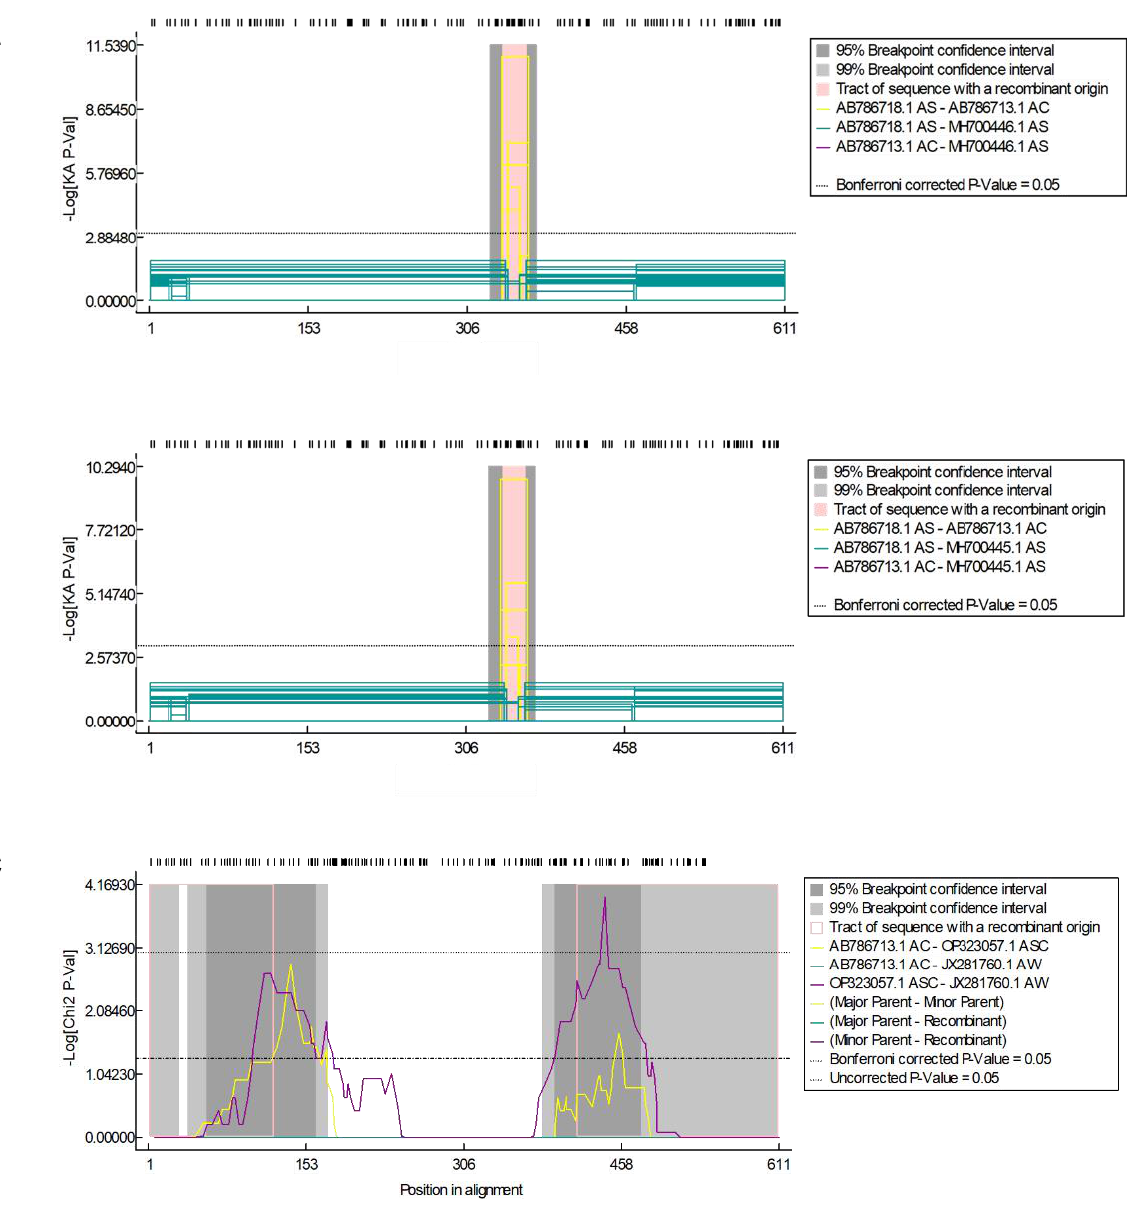
Figure 5. Recombination hotspots analysis. ( A , B ) Recombinant event 1 GENECONV output of se- quences ID MH700446.1 AS- MH700445.1 AS. ( C ) Recombination event 2 MaxChi output of the se- quence ID JX2817601. AW (possibly sequence ID OP323057.1 ASC is the real recombinant). The pink or pink border region denotes the presence of the recombination event, with the overlapping peaks on the plot serving as the recombination’s start and end breakpoints. The 99% and 95% confidence intervals for the breakpoint prediction are represented by the grey zone at the ends.